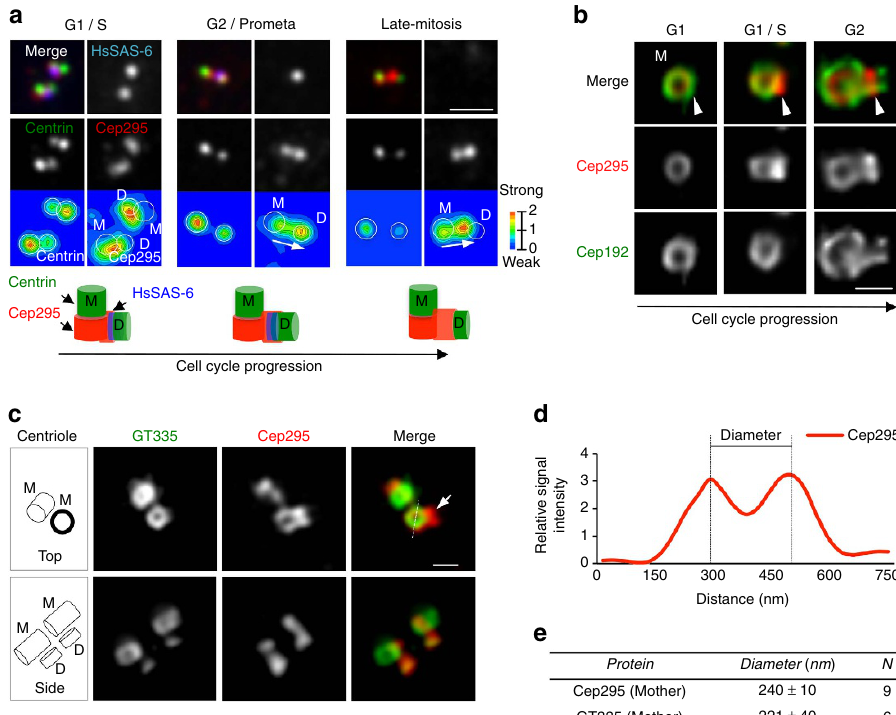
Figure 2 | Subcellular localization of Cep295 throughout the cell cycle. ( a ) Centriolar distribution of Cep295 at different cell cycle stages. HeLa cells were stained with the indicated antibodies. The bottom panels represent quantification of the local signal intensity of centrin (left) and Cep295 (right). The local signal intensity was visualized in the indicated colours (M: mother centriole; D: daughter centriole). The schematic models represent the localization of Cep295, HsSAS-6 and centrin during the cell cycle. Note that HsSAS-6 disappears in late mitosis. In G1/S phase, the centrosomal linker connects the proximal end of two mother centrioles. Scale bar, 1 m m. ( b ) Cep295 localizes to the assembly site of procentrioles in the earliest stage (arrowheads) and forms a ring-like structure. The images were obtained by TCS SP8 HSR system using antibodies against Cep192 (green) and Cep295 (red). Scale bar, 500nm. ( c ) 3D-SIM images representing top and side views of Cep295 at mother centrioles. GT335 was used as a centriole wall marker. An arrow points to recruitment of Cep295 onto the daughter centriole wall before the glutamylation of centriolar mitrotubules. Scale bar, 400nm. ( d , e ) The graph shows the signal intensity of Cep295 at the mother centriole along the dotted line in ( c ). For quantification of the diameter, the distances between intensity maxima were measured (mean ±